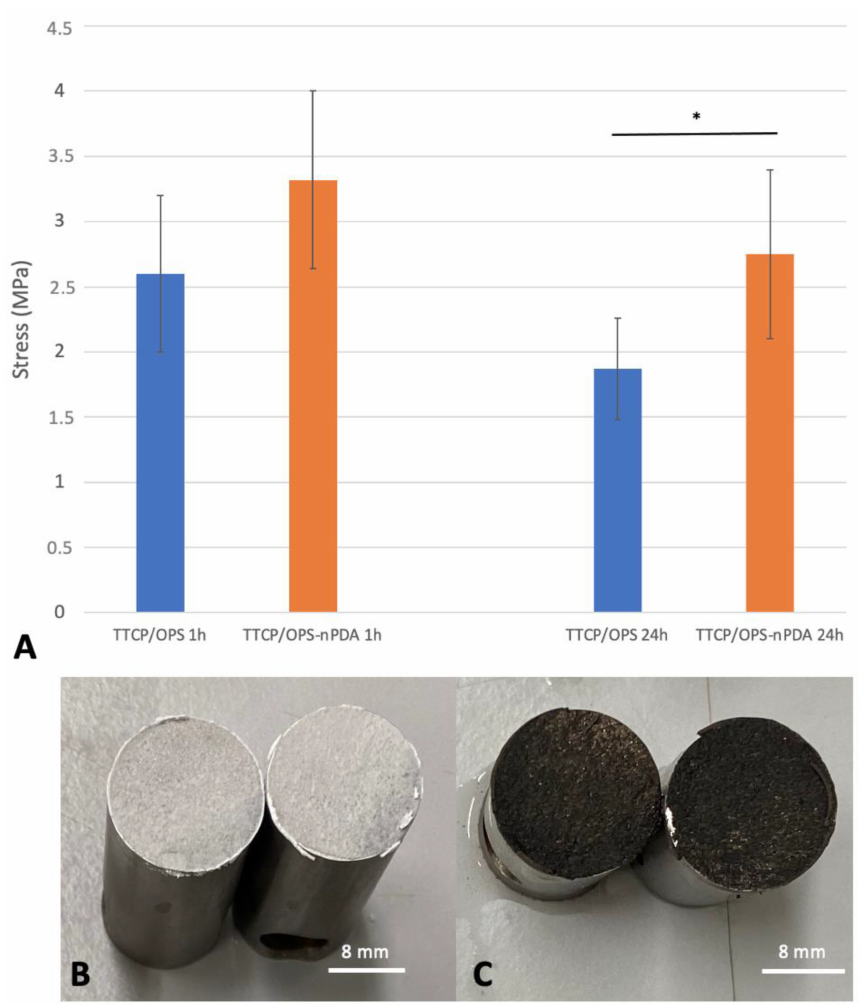
Figure 3. Instrumental tensile adhesion tests using titanium cylinder samples comparing TTCP/OPS glue versus TTCP/OPS-nPDA glue: ( A ) maximum traction stress after 1 h and 24 h immersions in a 37 ◦ C PBS bath. * stands for a statistically significant difference ( p = 0.0029) between two marked groups; surfaces of titanium samples glued with TTCP/OPS ( B ) or with TTCP/OPS-nPDA ( C ) after rupture, mostly showing a cohesive failure for